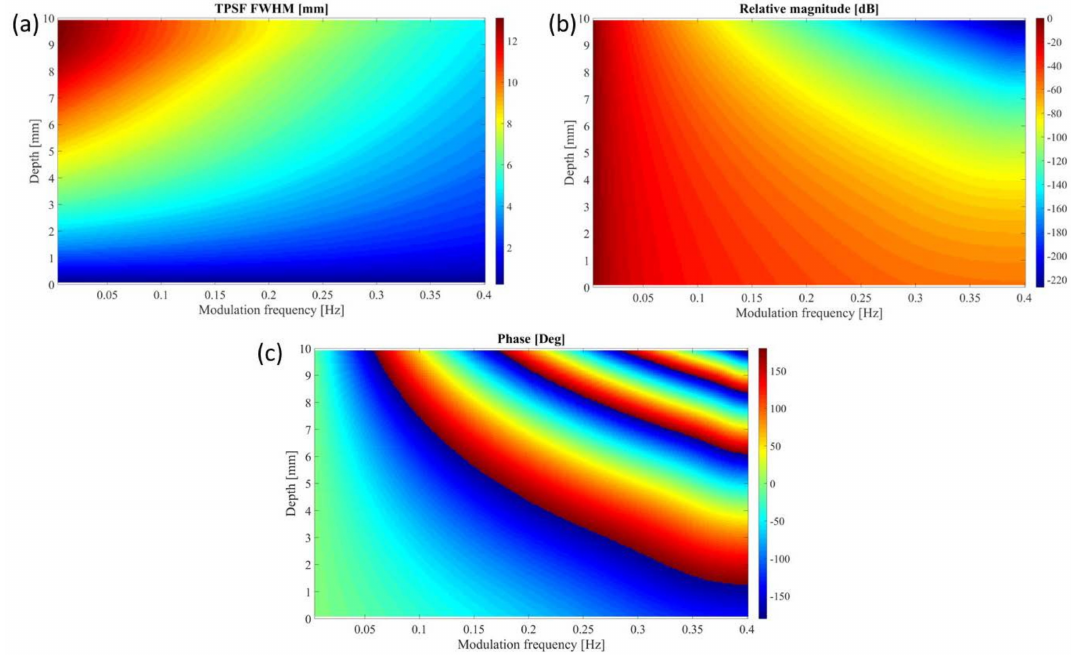
Figure 6. Characterization of the predicted Thermal PSF. ( a – c ) The TPSF for different depths and modulation frequencies. ( a ) Shows the FWHM in mm, ( b ) the relative magnitude in dB and ( c ) the phase of the